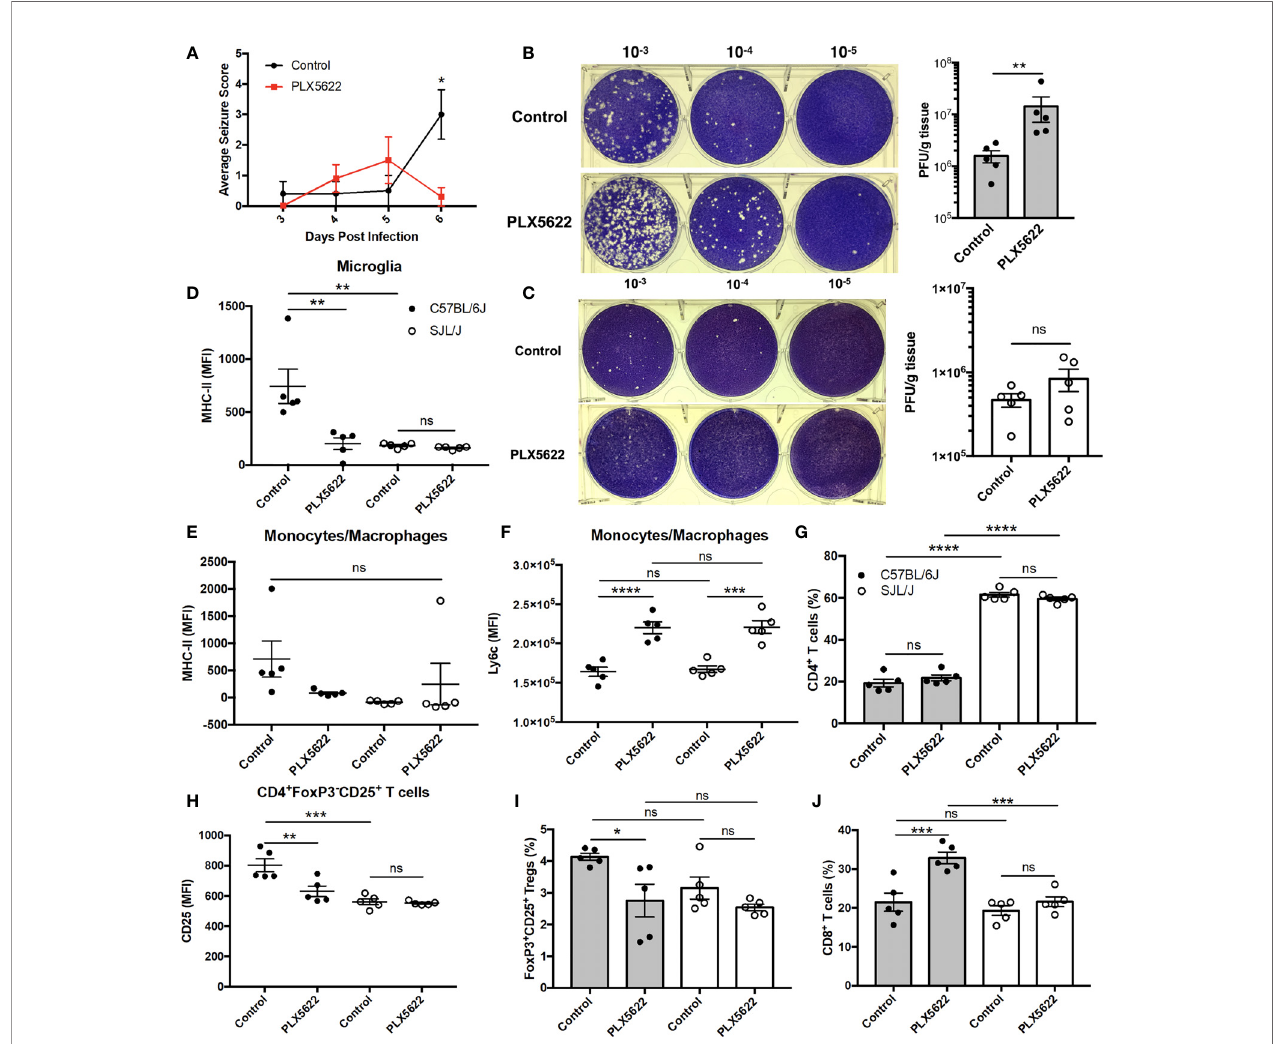
FIGURE 2 | The contribution of microglia to acute control of TMEV CNS infection depends on host genetic background. (A) Seizure severity over time in C57BL/6J mice treated with PLX5622 seven days prior to i.c. TMEV infection (n = 10 mice per group). Representative images and quanti fi cation of plaque assays from the brains of TMEV-infected (B) C57BL/6J mice and (C) SJL/J mice. MHC-II expression in CNS (D) microglia and (E) monocytes/macrophages. (F) Ly6c expression in CNS monocytes/macrophages. (G) Proportion of CNS CD4 + T cells. (H) CD25 expression in CNS CD4 + FoxP3 - CD25 + T cells. (I) Proportion of CD4 + FoxP3 + CD25 + Tregs of CNS CD4 + T cells. (J) Proportion of CD8 + T cells of CNS CD3 + T cells. Data are presented as mean ± SEM with 5 mice per group for (B – J) . *P ≤ 0.05, **P ≤ 0.01, ***P ≤ 0.001, ****P ≤ 0.0001, ns, not signi fi cant; Mann-Whitney U for (A) , Student t test for (B, C) , and one-way ANOVA for (D – J)